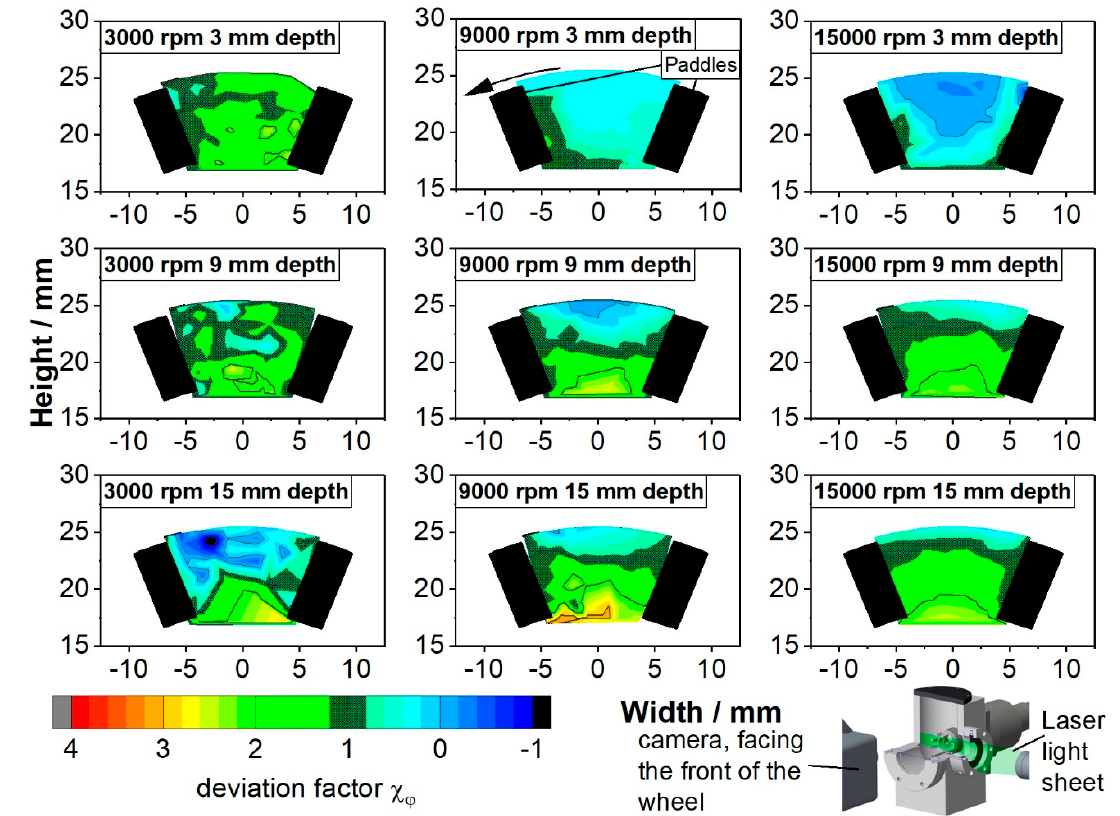
Figure 4. Measured tangential air velocity ( v φ ,meas ) divided by theoretically assumed v φ ,wheel (deviation factor χ φ ) at different rotor speeds and depths behind the front glass panel. The black areas indicate the deflector wheel paddles, rotating counterclockwise. In the measurement, the laser light sheet was facing the side, while the camera faced the front. For better visibility, the result was turned by 90 ◦ . The black dotted region between the blades indicates a deviation factor χ φ of 1 ± 20%, meaning only for this small region the usually assumed tangential air velocity approximately equals the deflector wheel classifier